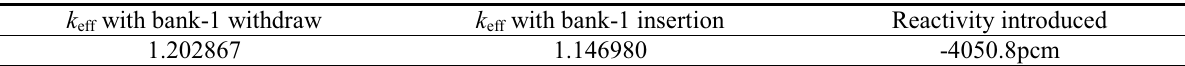
and reactivity introduced by bank-1 insertion of Table I. The k eff